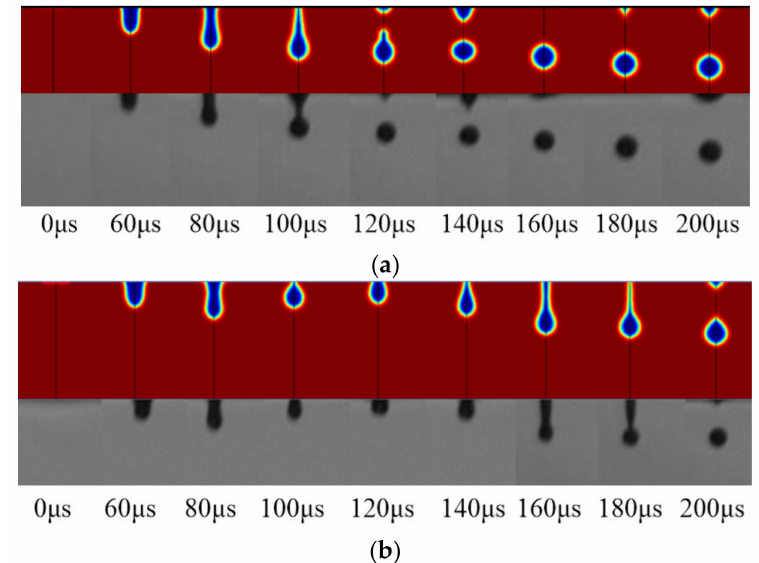
Figure 8. ( a ) Comparison of power-law fluid (PAM 0.2g/L) computational fluid dynamics (CFD) results and experimental results; ( b ) Comparison of power-law fluid (PAM 0.1g/L) CFD results and experimental